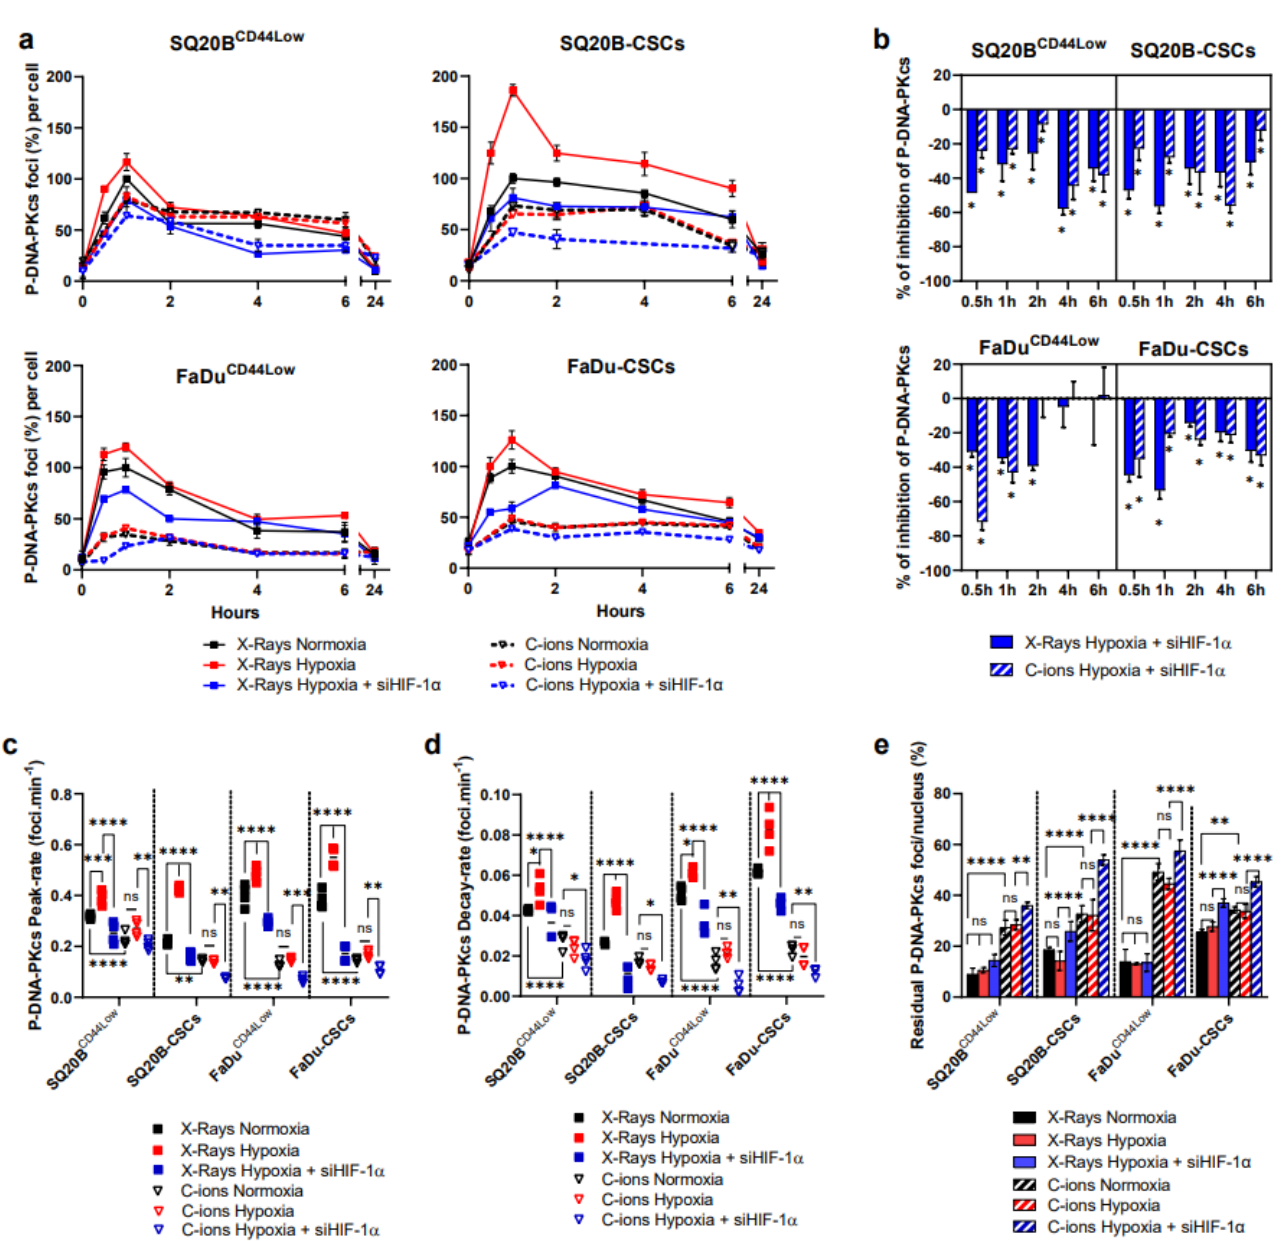
Figure 5. HIF-1 α silencing under hypoxia decreases the NHEJ-c pathway after both irradiations. ( a ) Kinetics of P-DNA-PKcs foci after X-rays and C-ions ± siHIF-1 α . The percentages of foci per nucleus were calculated for each condition considering the X-ray normoxic peak as the reference (means ± SD). ( b ) Effect of HIF-1 α silencing under hypoxia on P-DNA-PKcs expression. The percentages between hypoxia ± siHIF-1 α were statistically compared (Student’s t-Tests, Holm–Sidak method, α = 0.5) ( n = 3 photons; n = 2 C-ions). ( c , d ) represent respectively the induction-rate of the P-DNA-PKcs peak from the basal levels, and its decay-rate from the peak to 6 h, as determined from the data shown in ( a ) (two-way ANOVA test, * p < 0.05, ** p < 0.01, *** p < 0.001, **** p < 0.0001, ns: non-significant). ( e ) Residual foci were quantified at 24 h and each condition was compared to their respective normoxic condition (two-way ANOVA test) ( n = 3 photons, n = 2 C-ions).